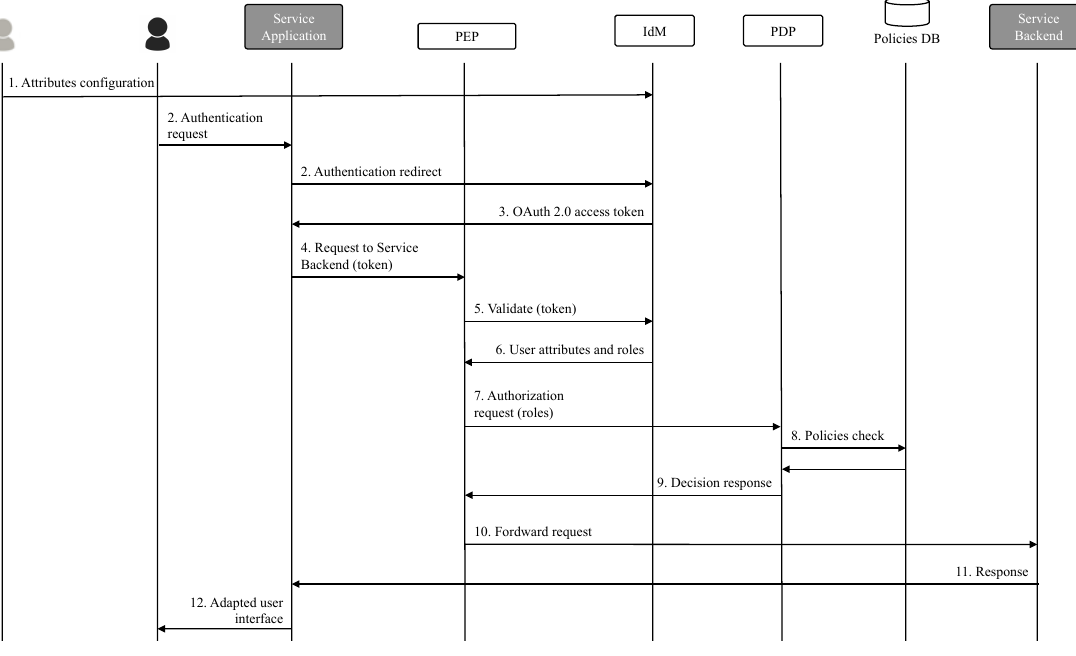
Figure 4. Advanced flow with access